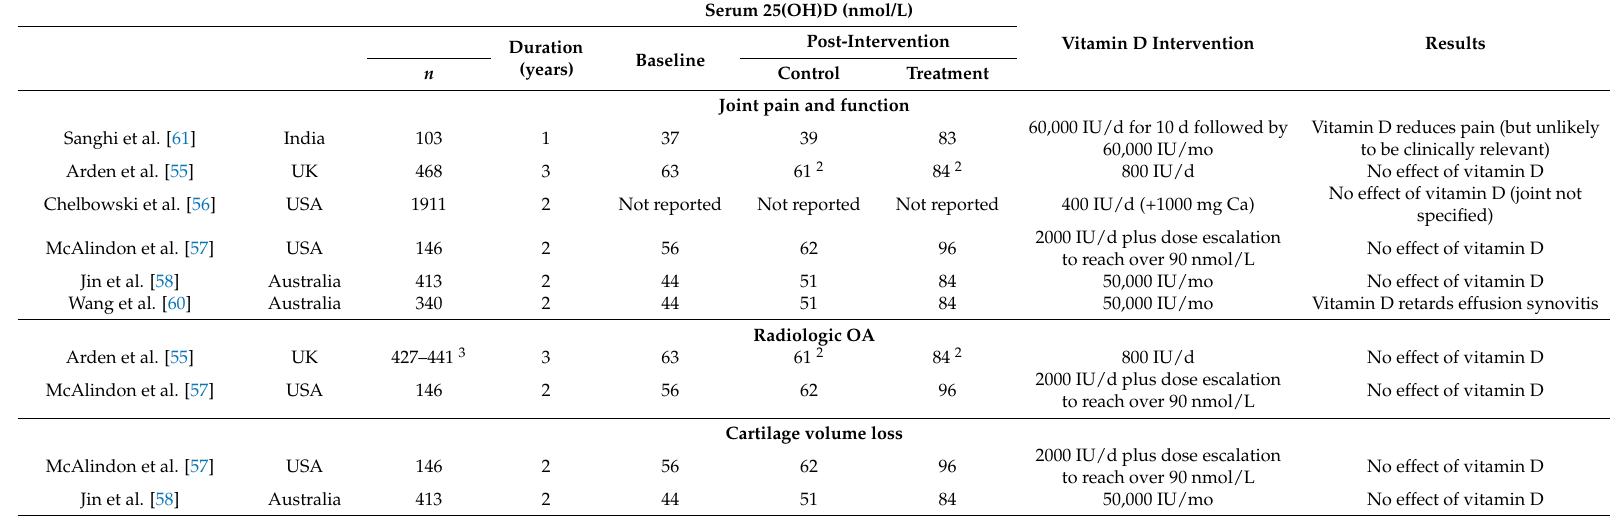
Table 2. Randomized clinical trials of vitamin D supplementation on the progression of knee osteoarthritis (OA) and related symptoms 1 . Serum 25(OH)D (nmol/L) Post-Intervention Vitamin D Intervention ResultsDuration (years) Baseline n Control